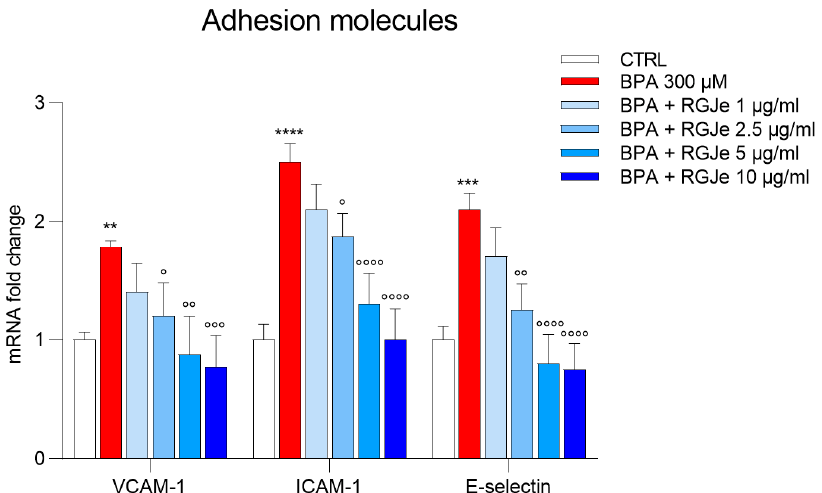
Figure 8. RGJe reduced the BPA-induced mRNA increase of VCAM-1, ICAM-1, and E-selectin adhesion molecules in HUVECs. The results from RT-PCR are expressed as an n-fold change compared to untreated cells, after normalization against β -actin as endogenous control. Data represent the mean ± SEM of three different sets of experiments performed in triplicate (n = 9). ** p < 0.01, *** p < 0.001, and **** p < 0.0001 vs. CTRL; ° p < 0.05, °° p < 0.01, °°° p < 0.001, and °°°° p < 0.0001 vs. BPA 300 µM.